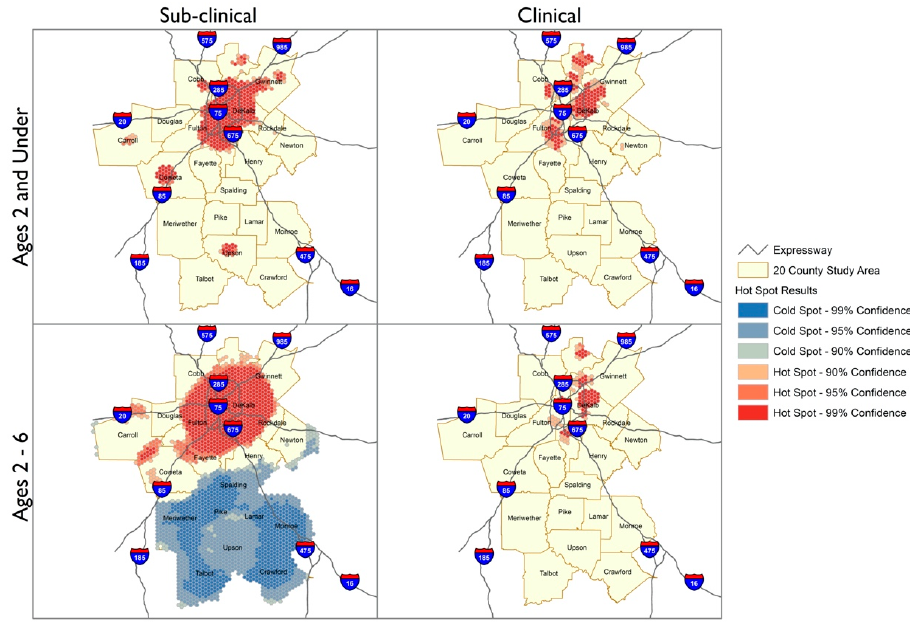
Figure 3. Comparison of Hotspot Analysis Distribution Patterns between Sub-clinical and Clinical BLLs for the year 2018. Hotspot analysis of the 90–99% confidence regions of hotspots for BLLs 2 to <5 µg/dL (Sub-clinical) and BLLs ≥ 5 µg/dL (Clinical) for 20-county metro Atlanta area in 2018. BLLs 2 to <5 µg/dL and BLLs ≥ 5 µg/dL are shown as red pattern dots with the darkest shaded regions reflecting the 99% confidence area.